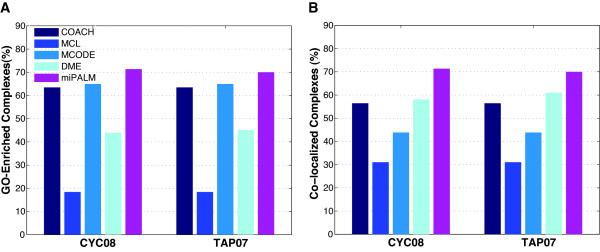
Biological relevance of predicted complexes by five algorithms with optimized parameters and the DIP PPI network as input. A) Percentage of complexes enriched for at least one GO term. B) Percentage of complexes whose members are co-localized in the same sub-cellular compartment.